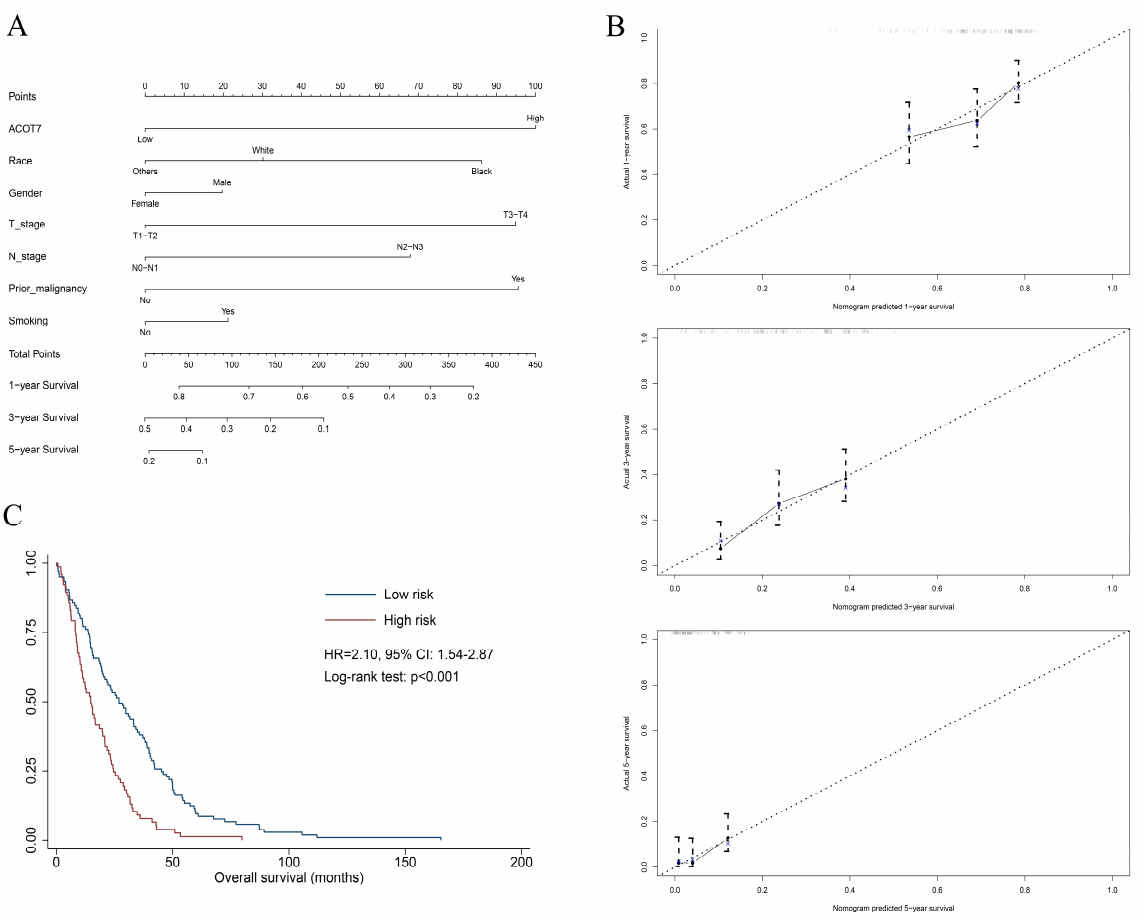
Figure 3. Nomogram based on multivariate Cox regression model to predict overall survival of LUAD patients using TCGA dataset. ( A ) Nomogram; ( B ) calibration plots of 1-, 3-, and 5-year overall survival; ( C ) Kaplan–Meier curve of patients in different risk groups (high-risk: score > 225; low-risk: score ≤ 225). Abbreviations: ACOT7, Acyl-CoA thioesterase 7; LUAD, lung